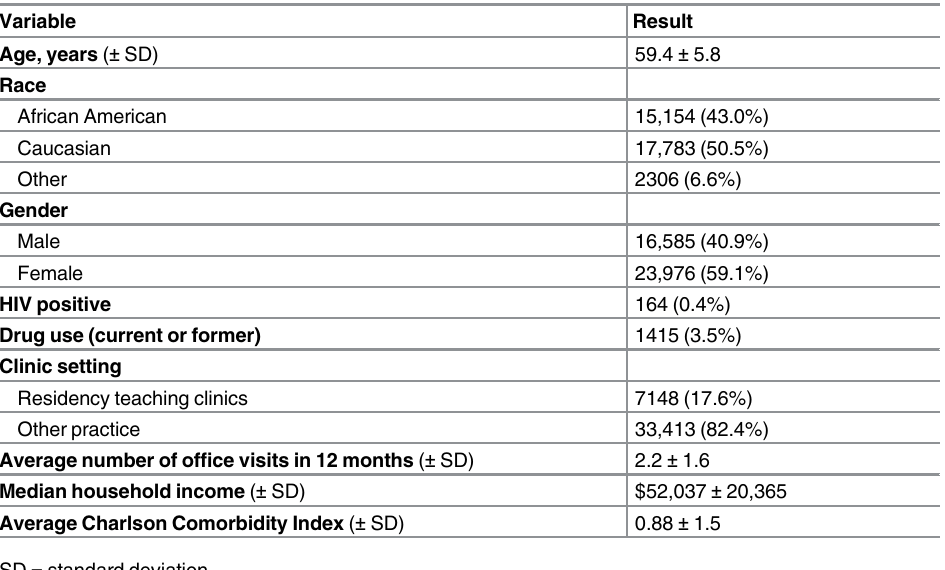
Table 1. Birth Cohort Demographic